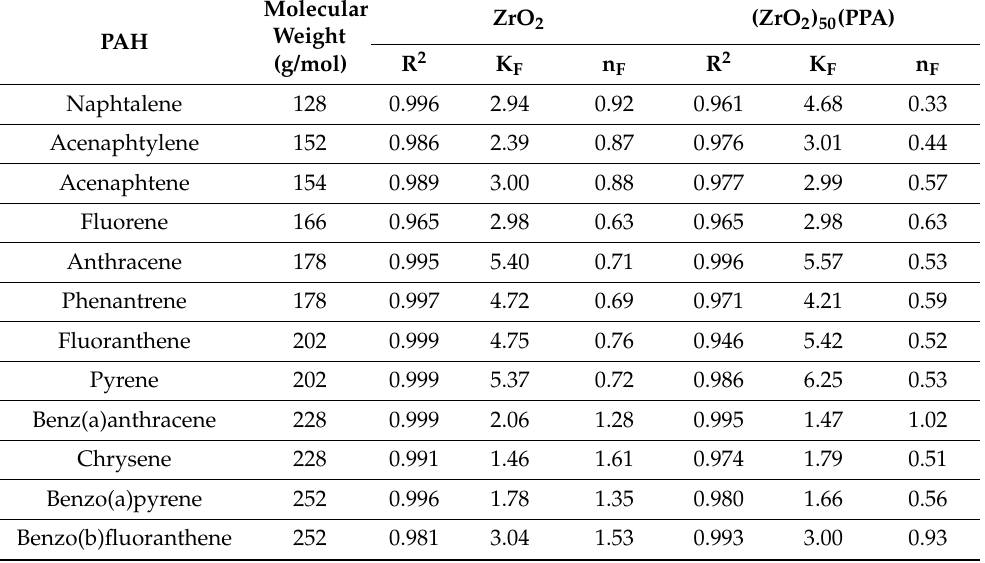
Table A3. Freundlich parameters, and fit accuracy using the slope of the linear plot of lnqe versus lnCe for the adsorption of 16 PAHs onto (ZrO 2 ) and (ZrO 2 ) 50 (PPA)